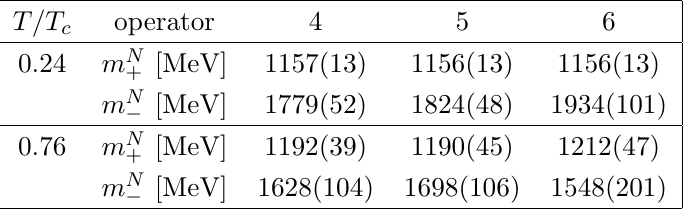
at T=T c = 0 : 24 ; 0 : (cid:6)